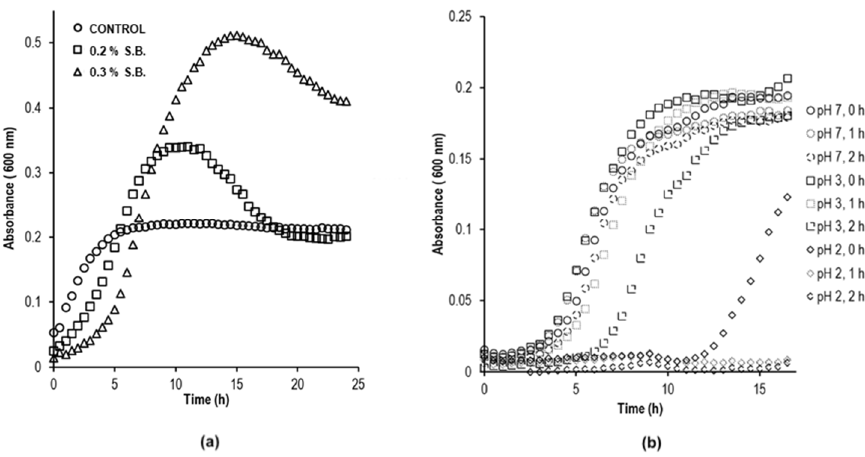
Figure 1. Kinetic growth for B. pumilus UAMX in the presence of ( a ) bile salts 0, 0.2 or 0.3% and ( b ) after exposure to pH (2, 3 and 7) for up to 2 h. Data were adjusted as indicated by the experimental procedures.